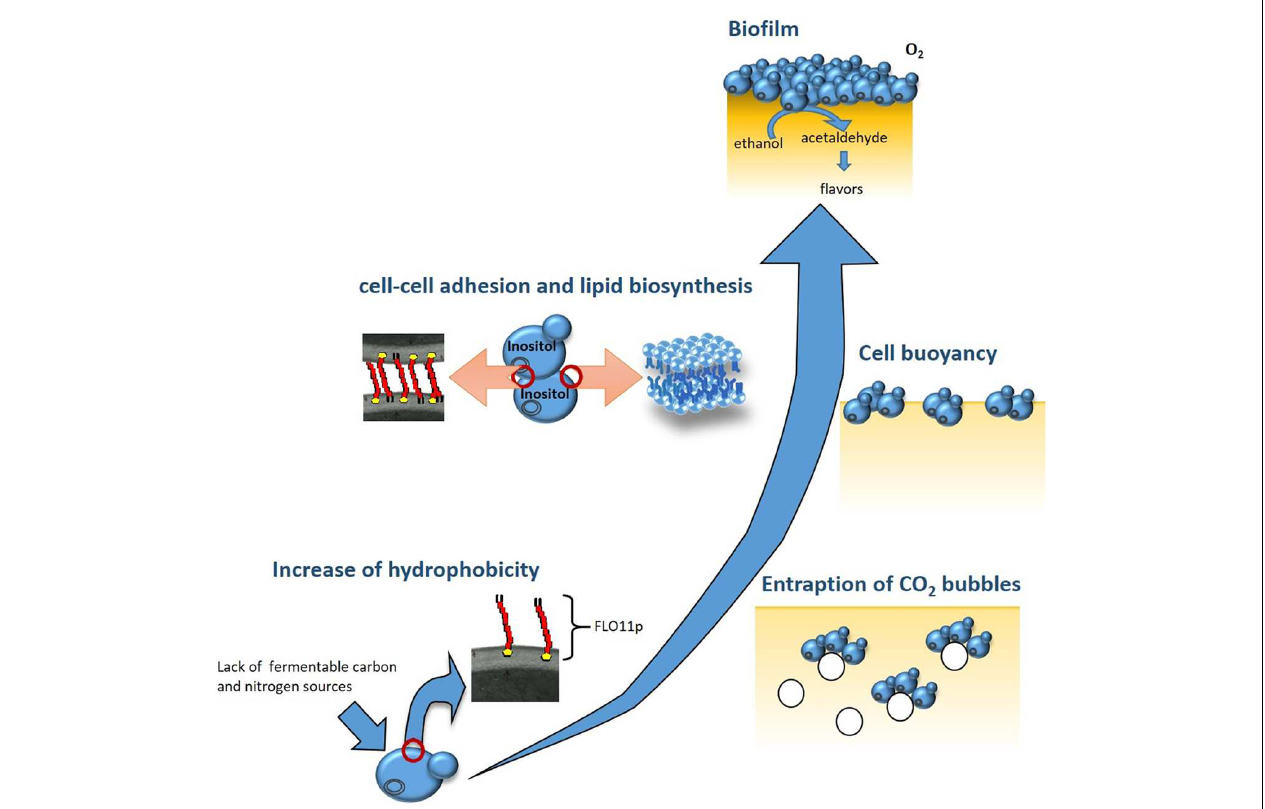
FIGURE 1 | Building of the biofilm by flor yeast. At the end of fermentation, Saccharomyces cerevisiae flor yeast adapt to the lack of fermentable carbon and nitrogen sources by triggering specific metabolic pathways: cAMP-protein kinase A (PKA), mitogen-activated protein kinase (MAPK), and TOR. These, in turn, activate the transcription of FLO11 , which codes for a hydrophobic protein. The higher cell surface hydrophobicity encourages formation of multicellular aggregates that entrap CO 2 bubbles and float toward the wine surface. In biofilm cells overexpressing FLO11 , inositol is used for the assembly of the glycosylphosphatidylinositol anchor of Flo11p. The decrease in the intracellular concentration of inositol and the availability of oxygen on the wine surface activate the expression of genes regulated by inositol–choline responsive elements, such as ACC1, which results in the de-novo biosynthesis of unsaturated fatty acids and in increased cell buoyancy. The different cell layers that constitute the mature biofilm protect the wine from direct exposure to oxygen, and induce important changes in the organoleptic, aromatic and chemical composition of the